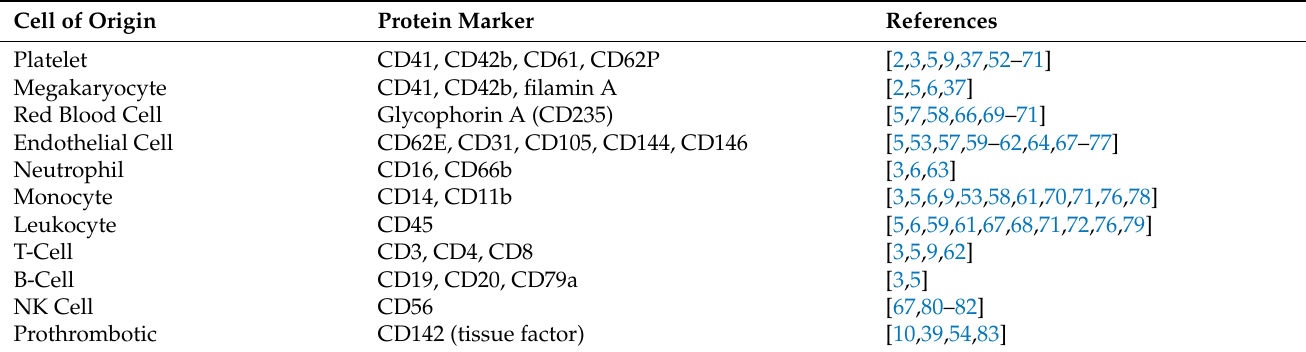
Table 1. Cell-type specific markers of